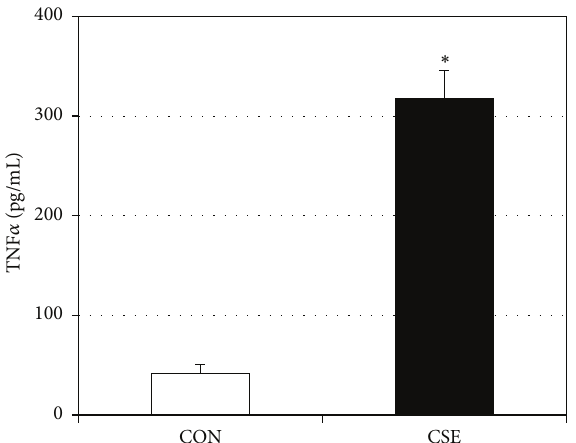
Figure 3: CSE-treated gingival cells release TNF 𝛼 . Ca9-22 gingival cells were treated with control (CON) or CSE-treated medium for 4 h, followed by 4 h of fresh medium. At the end of the 4h, culture medium was transferred and centrifuged for 5 min at 2,500 rpm. TNF 𝛼 was analyzed via ELISA ( 𝑛 = 4 ). ∗ 𝑃 < 0.05 : CSE versus CON.